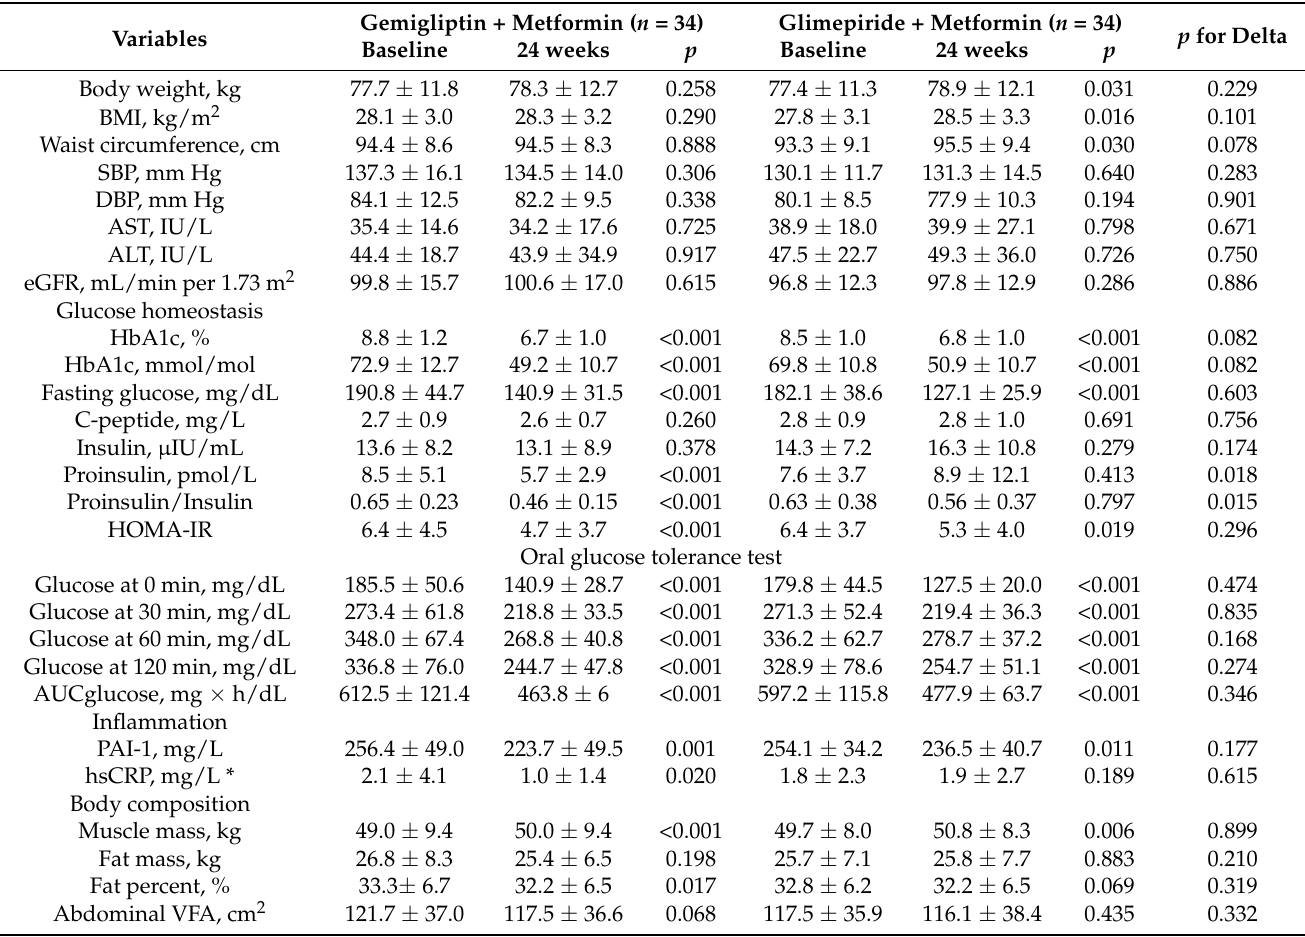
Table 2. Investigational parameters at the baseline and after 24 weeks of